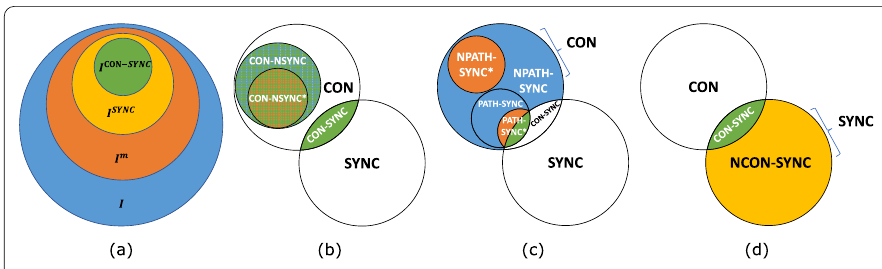
Figure 16 Illustration of test and reference sets for statistical tests performed in Sects. 4.2–4.4. ( a ) illustrates the relationship between different sets of investor nodes. Investors who synchronize their trades with at least